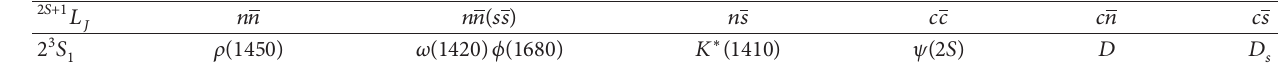
Table 1: Assignment of the 2 3 𝑆 1 meson state in PDG